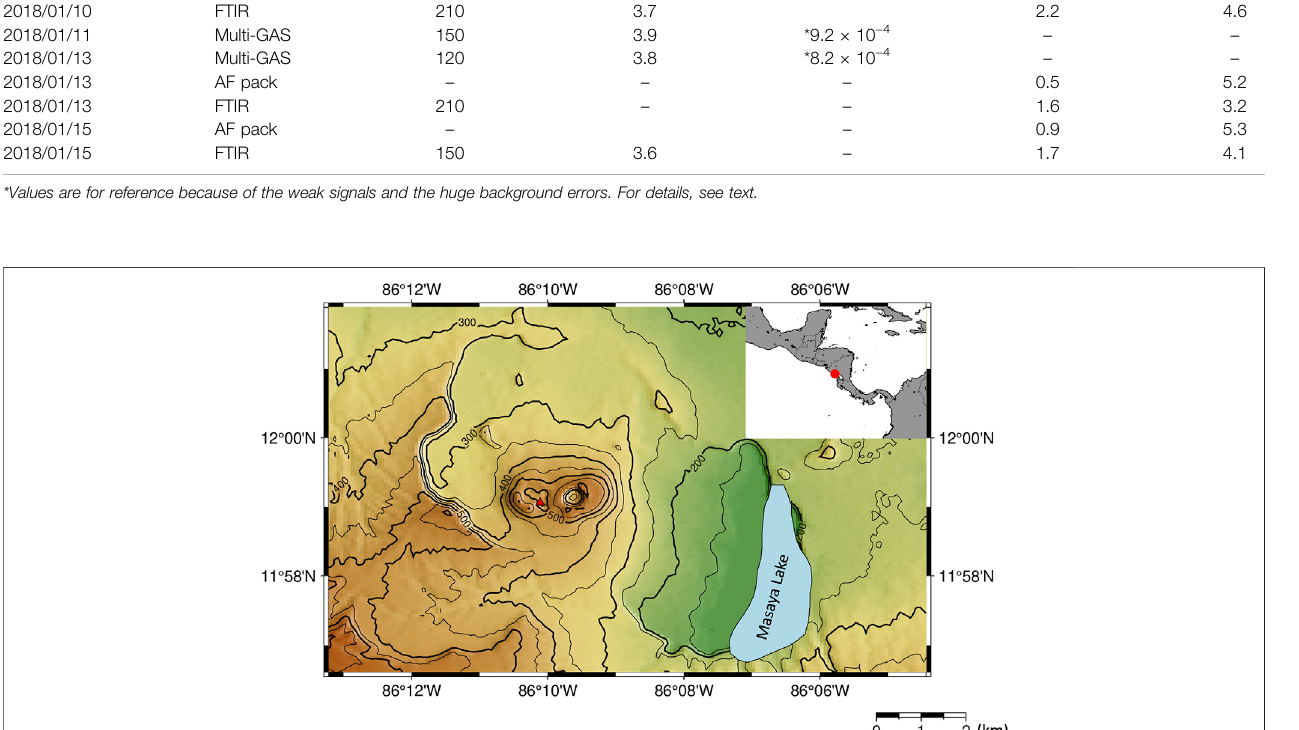
FIGURE1| MapofMasayaVolcano.Theredtrianglerepresentsthelocationofalavalake.InsetshowsthelocationofMasayaVolcano(redcircle)withinNicaragua.